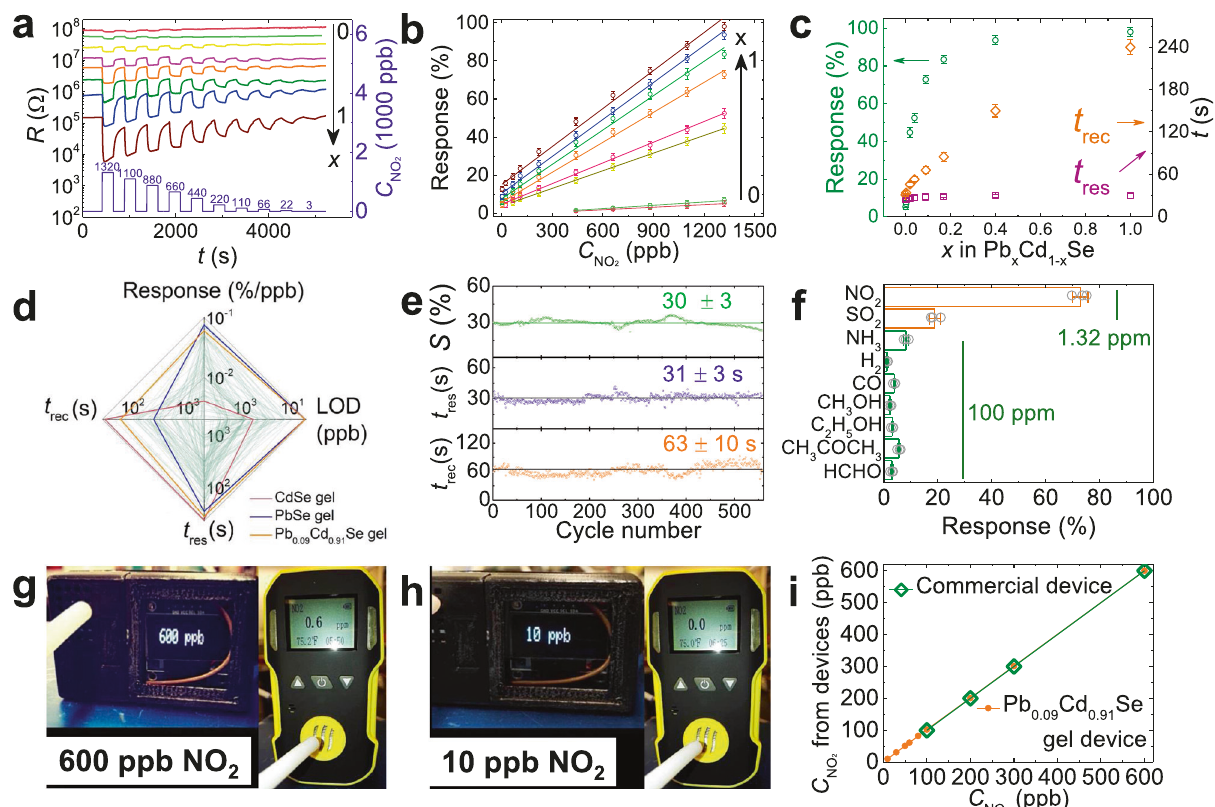
Fig. 4 Gas-sensing performance of Pb x Cd 1 − x Se QD gels at room temperature. a Response – recovery curves of Pb x Cd 1 − x Se QD gel sensors to NO 2 at different concentrations (3 ppb – 1.32 ppm) at room temperature ( x = 0.003, 0.02, 0.04, 0.09, 0.17, 0.40, and 1.0). b Sensor response vs NO 2 concentration ( C NO2 ) plots. c Sensor response ( S ), response time ( t res ), and recovery time ( t rec ) of Pb x Cd 1 − x Se QD gels towards 1.32 ppm NO 2 as a function of x . d Comparison between CdSe, PbSe, Pb 0.09 Cd 0.91 Se QD gels, and 110 state-of-the-art room-temperature p-type NO 2 gas sensors in